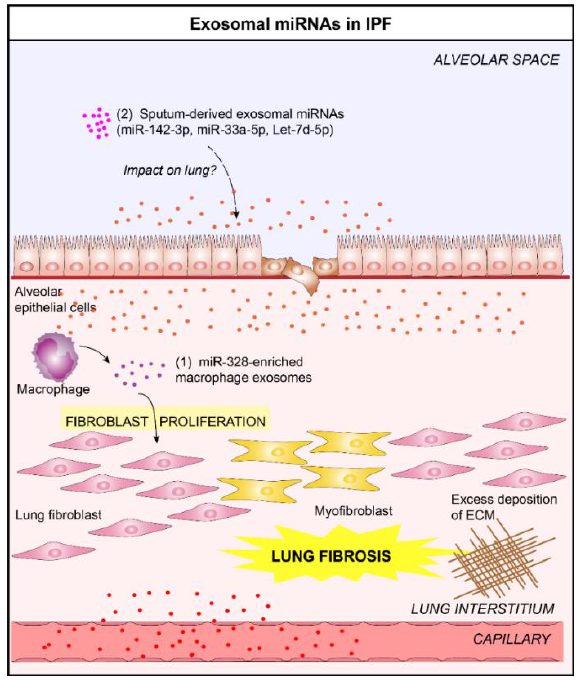
Figure 5. Role of lung EVs in the pathogenesis of Idiopathic Pulmonary Fibrosis (IPF). ( 1 ) In the context of IPF, macrophage-derived EVs promote the progression of pulmonary fibrosis by delivering miR-328 to pulmonary interstitial fibroblasts which enhances their proliferation [65]. ( 2 ) Altered levels of three exosomal miRNAs (miR-142-3p, miR-33a-5p, let-7d-5p) in the sputum of IPF patients have been reported [25]. These exosomal miRNAs could play a crucial role in the IPF progression. Collectively, these studies reveal that exosomal miRNAs possess a detelerious e ff ect in the context of lung diseases. Their properties (pro-inflammatory or pro-fibrotic) depend on the disease type and its stage, and allow them to promote the progression of lung